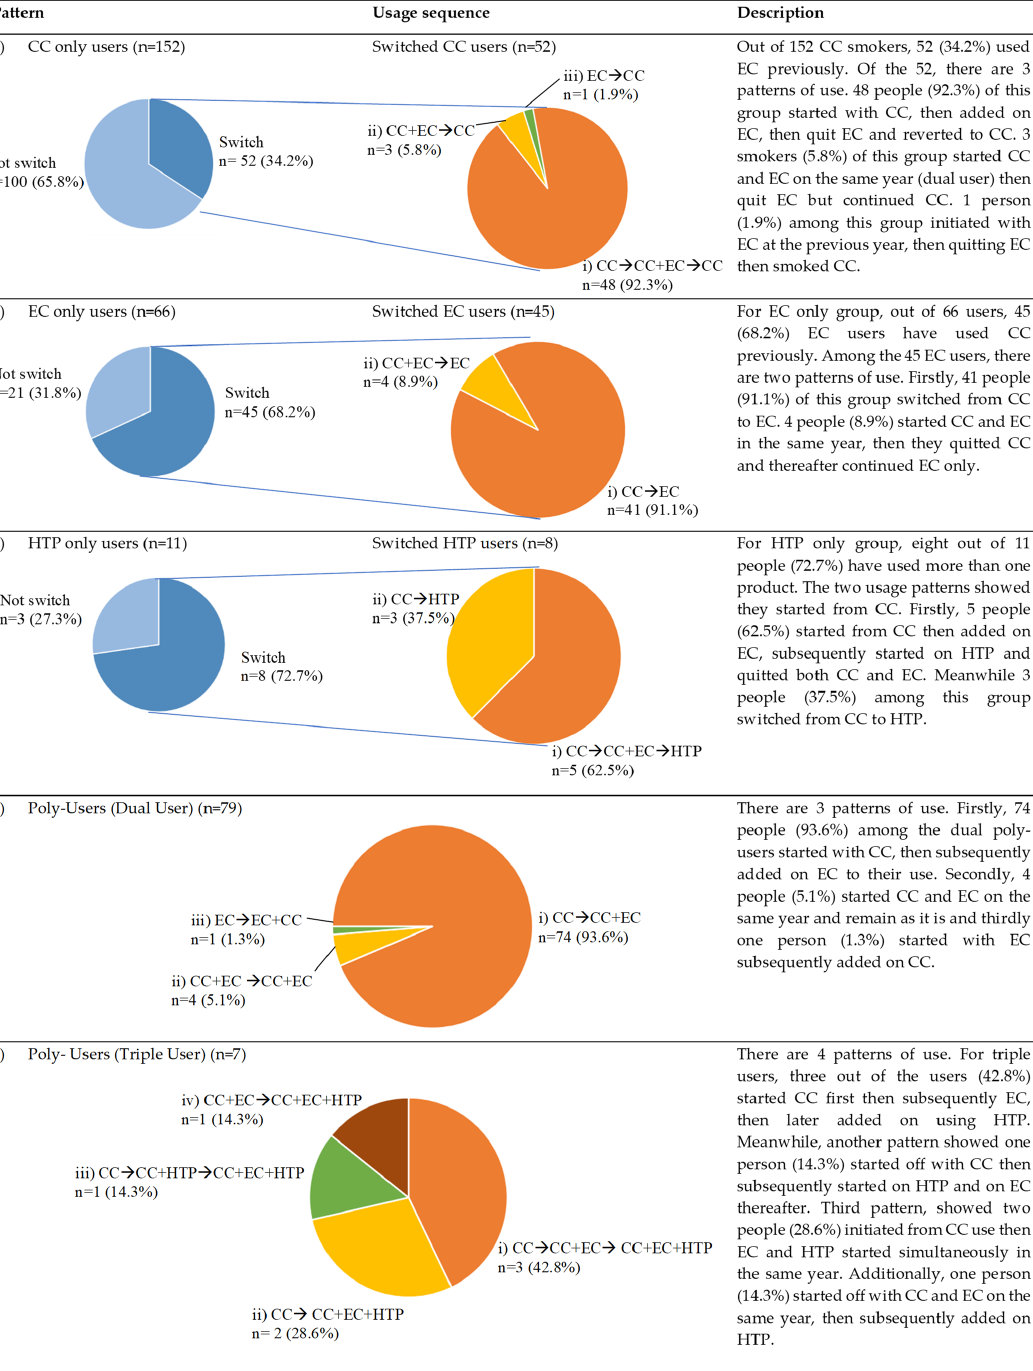
Figure 2. Pattern and usage sequence of product use.